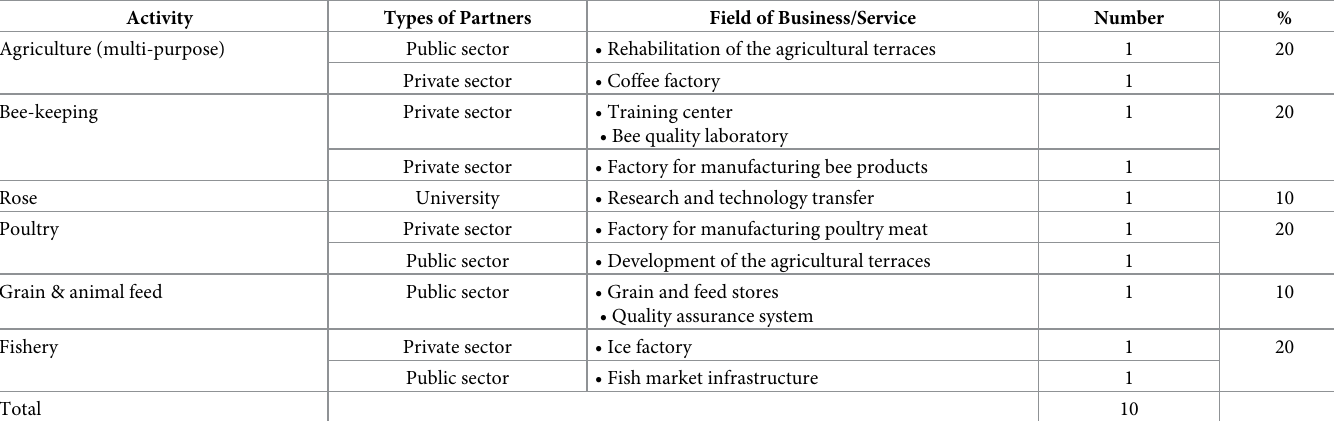
Table 8. Distribution of the partnerships based on the field of services or business built, cooperatives’ activities, and partners participated.